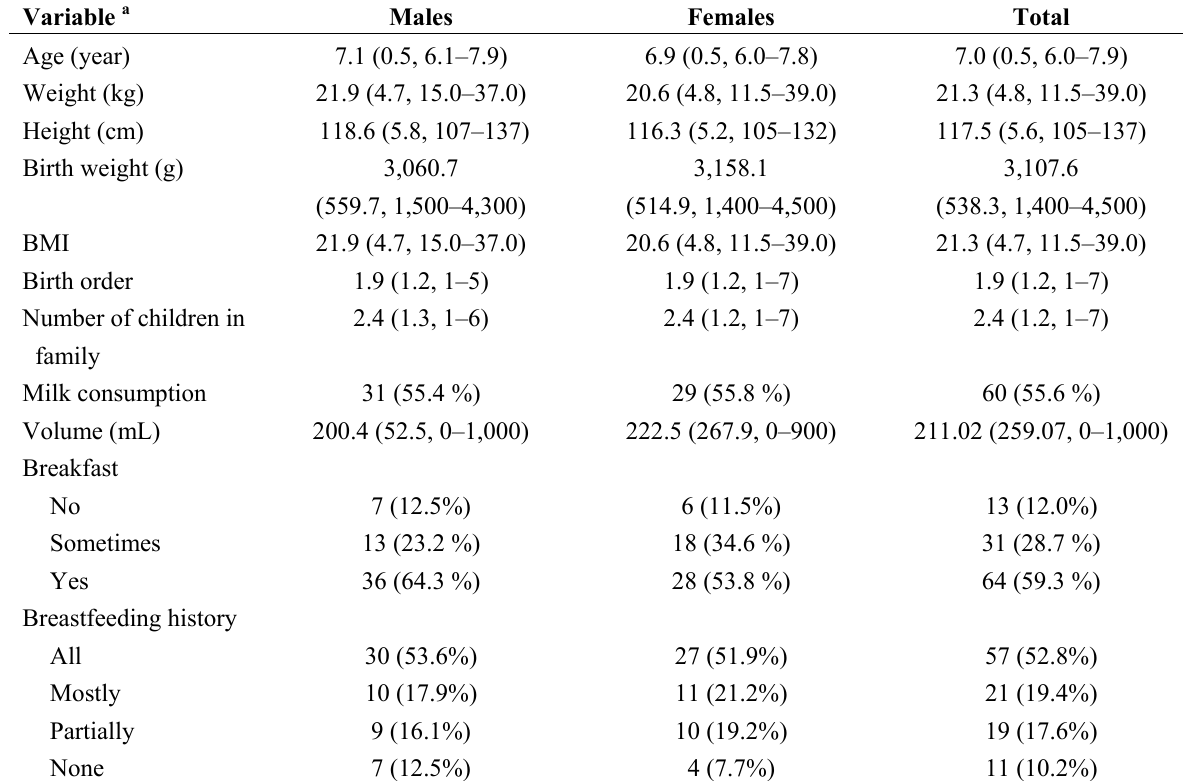
Table A1. Characteristics of the study children.